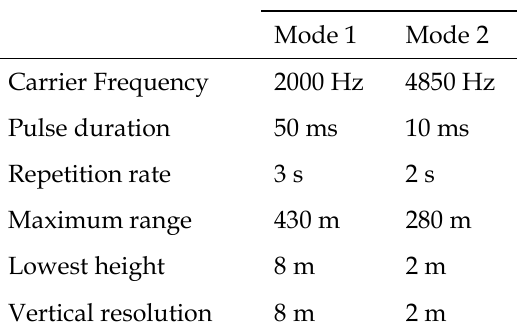
Table 1 . SL-sodar setting